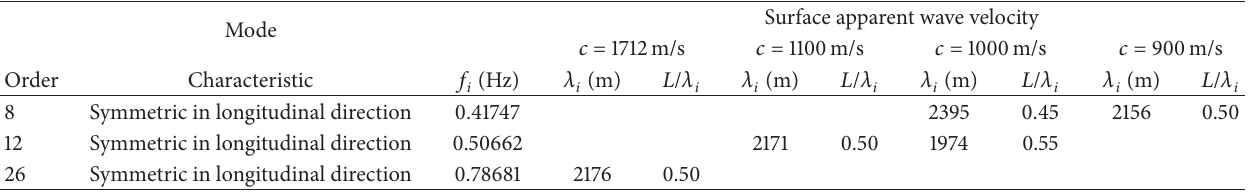
Table 2: Relationships between the main span, structural natural frequencies, apparent wave velocity, and wavelength. Mode